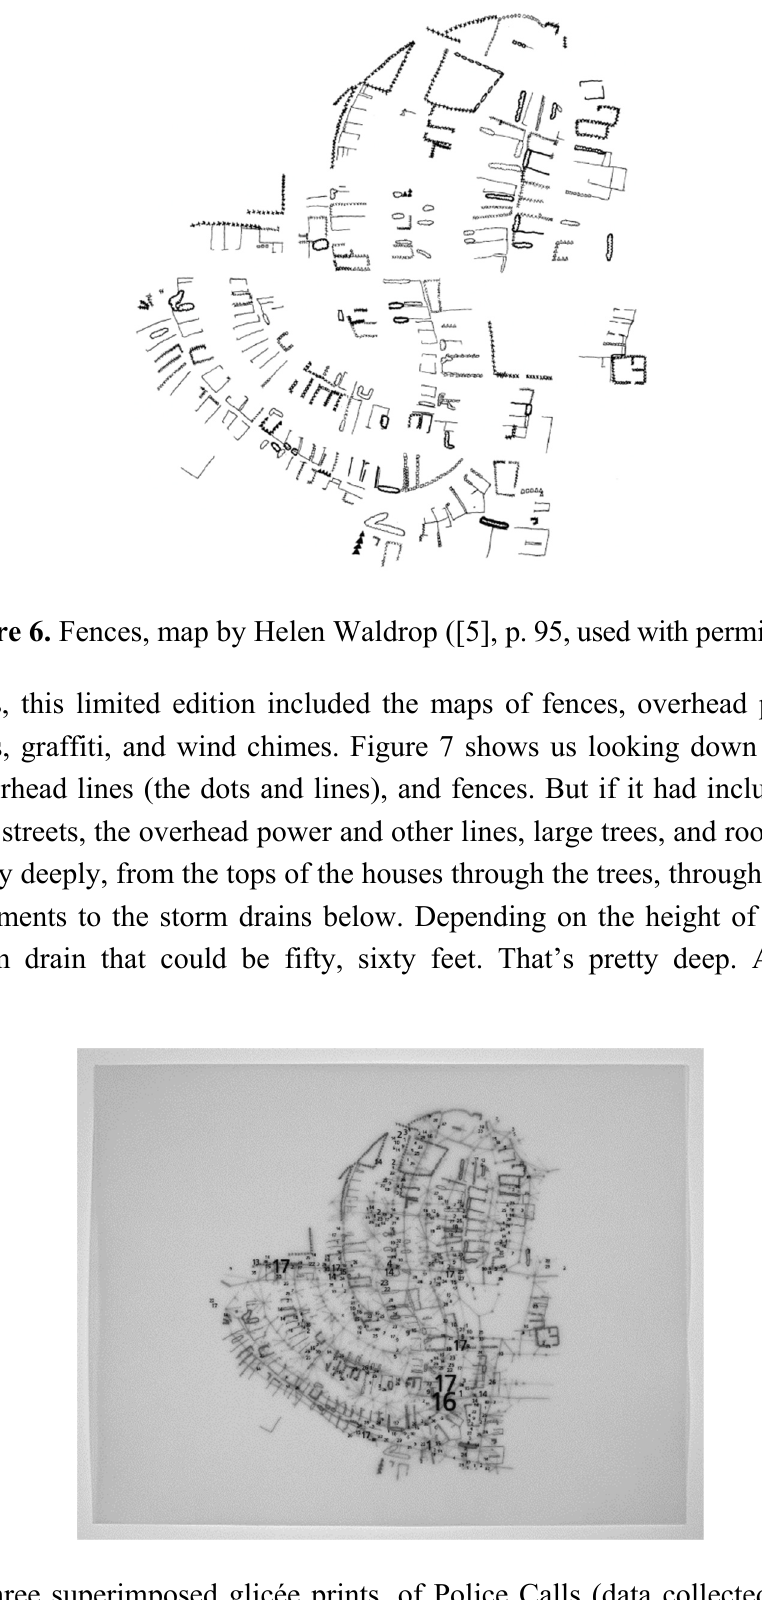
Figure 7. Three superimposed glicée prints, of Police Calls (data collected by numerous students, map by Denis Wood), Squirrel Highways (data collected by Shaub Dunkley, Carter Crawford and Denis Wood, map by Carter Crawford), and Fences (map by Helen Waldrop) ([8] used with